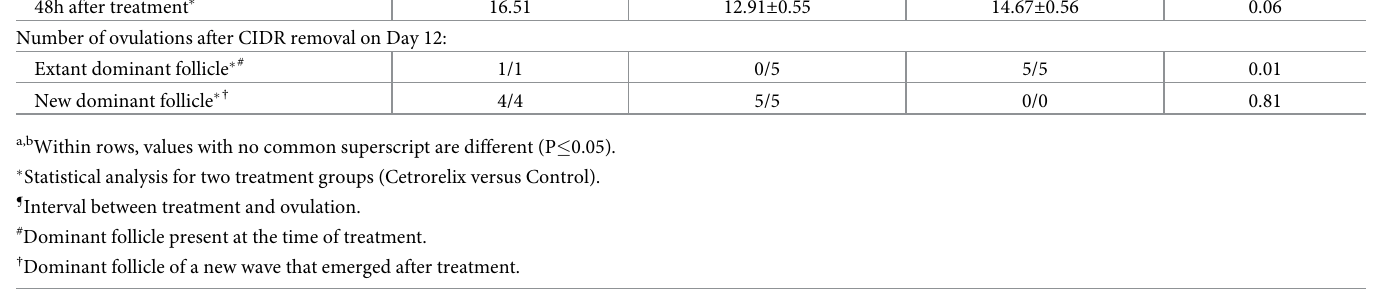
population in the medial preoptic area and second aggregation in the caudal portion of arcuate nucleus [50], and in cows the majority of kisspeptin neurons are detected in the rostral and middle regions of the arcuate nucleus [10,51]. In contrast, GnRH neurons are scattered in the diagonal band of Broca, the medial preoptic area and anterior hypothalamus [52], while the median eminence has a high density of GnRH positive nervefibers close proximity to kisspep- tin fibers and portal blood vessels in cows (unpublished) and in primates [7]. The effect of peripheral kisspeptin on the GnRH cells could be exerted at the neuronal terminals in the